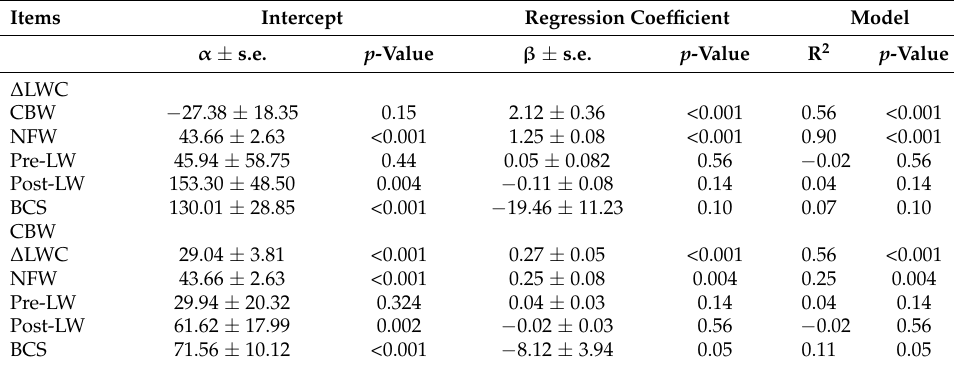
Table 3. Prediction equations for cow liveweight change at calving ( ∆ LWC) and calf birth weight (CBW) from the non-foetal weight (NFW), cow pre-calving liveweight (pre-LW), and cow post-calving liveweight (post-LW) in the 28 cow–calf pairs, alongside the regression coefficient ( β ), intercept ( α ), R 2 , standard error (s.e.) and p -value for the intercept regression coefficient and model. Items Intercept Regression Coefficient Model α ± s.e. p -Value β ± s.e. p -Value R 2 p -Value ∆ LWC CBW − 27.38 ± 18.35 0.15 2.12 ± 0.36 <0.001 0.56 <0.001 NFW 43.66 ± 2.63 <0.001 1.25 ± 0.08 <0.001 0.90 153.30 ± 48.50 0.004 − 0.11 ± 0.08 0.14 0.04 0.14 BCS 130.01 ± 28.85 <0.001 − 19.46 ± 11.23 0.10 0.07 0.10 CBW ∆ LWC 29.04 ± 3.81 <0.001 0.27 ± 0.05 <0.001